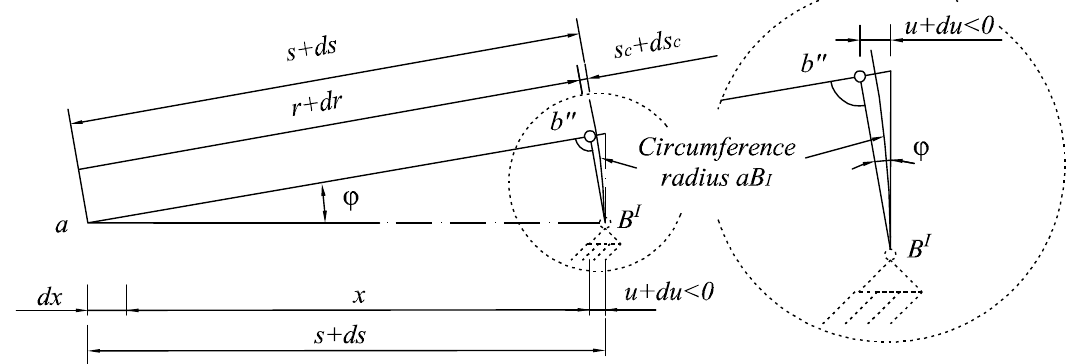
Figure 6. Polar coordinates for the right segment of the parabola a-b (Phase II). Radius ab ″